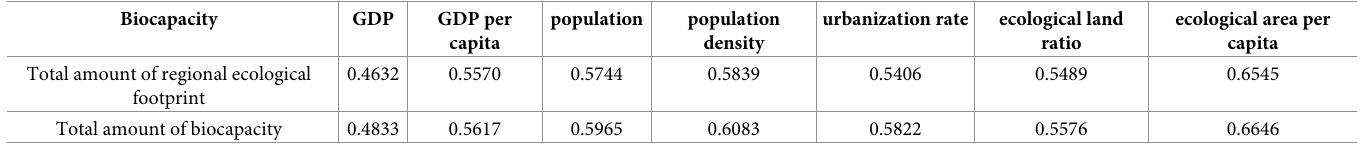
Table 1. Correlation between biocapacity and influencing factors in Shenyang from 2005 to 2019.